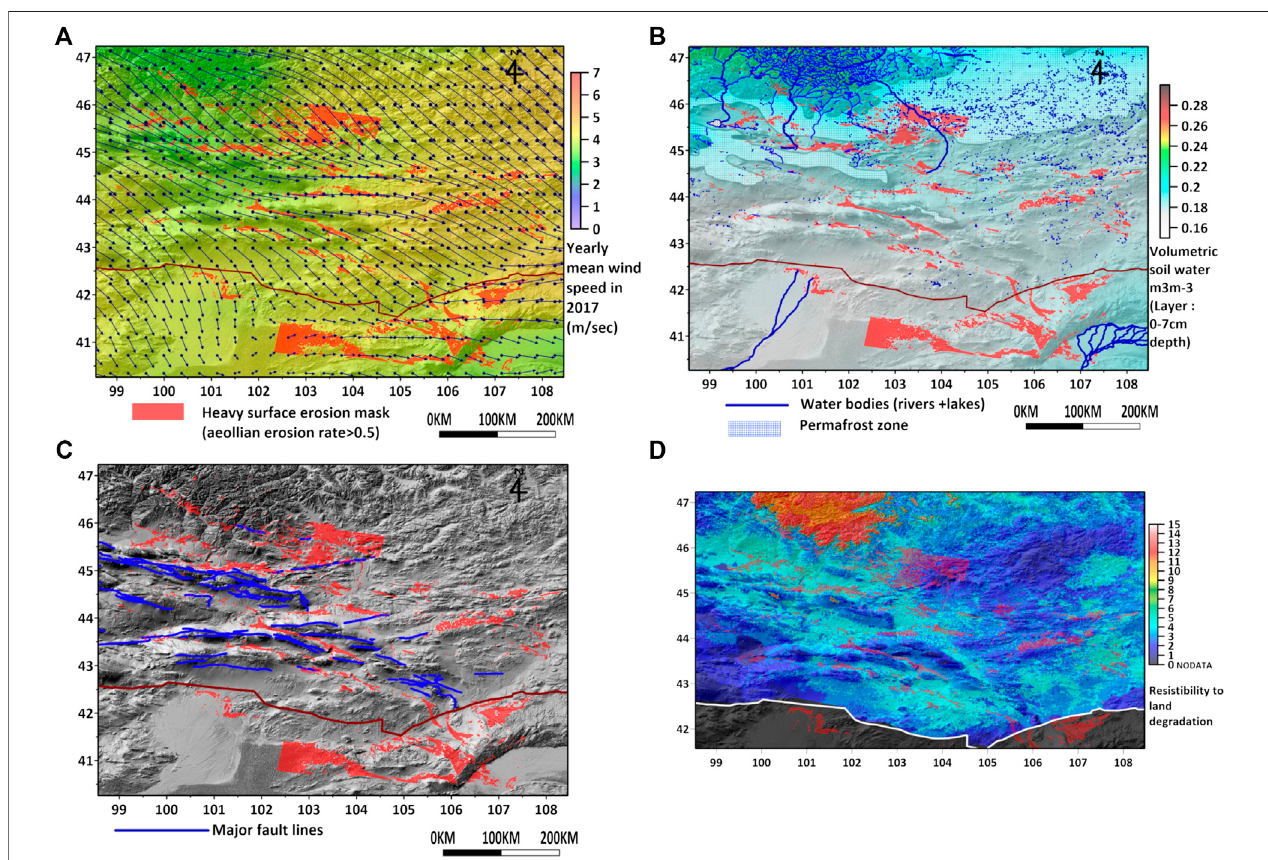
FIGURE 3 | (A) The extent of heavy surface erosion (eolian erosion rate > 0.5) along with the yearly mean ECMWF wind information in 2017, also with (B) the hydrological contexts, (C) the geological structures (Bayasgalan et al., 2020), and (E) the land degradation rate by the empirical analysis with vegetation indexes. The details of comparison data sets were given in the Supplementary Material